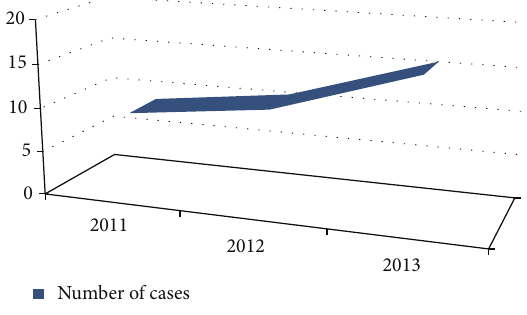
Figure 6: Year-wise diagnosed cases of